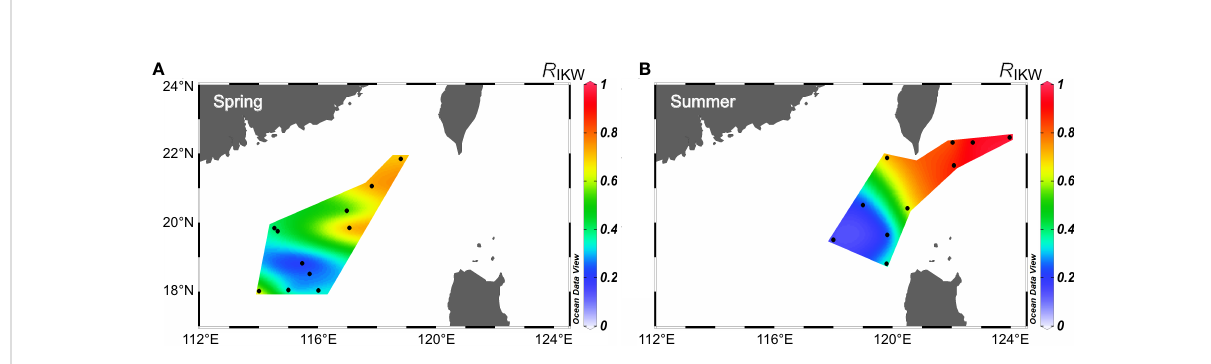
FIGURE 6 Station-integrated Kuroshio water fraction ( R IKW ) in the upper 100 m of the northern SCS during spring (A) and summer (B)